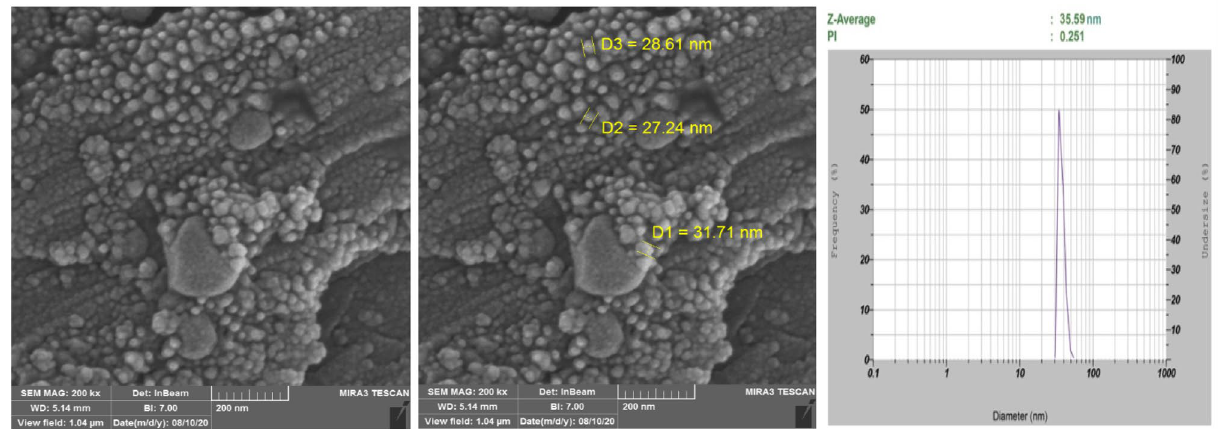
Figure 1. S.E.M. images of exosomes isolated from adipose mesenchymal stem cells. The DLS results also demonstrated that the Z-Average of vesicles is 35.59 nm with a PdI (polydispersity index) of